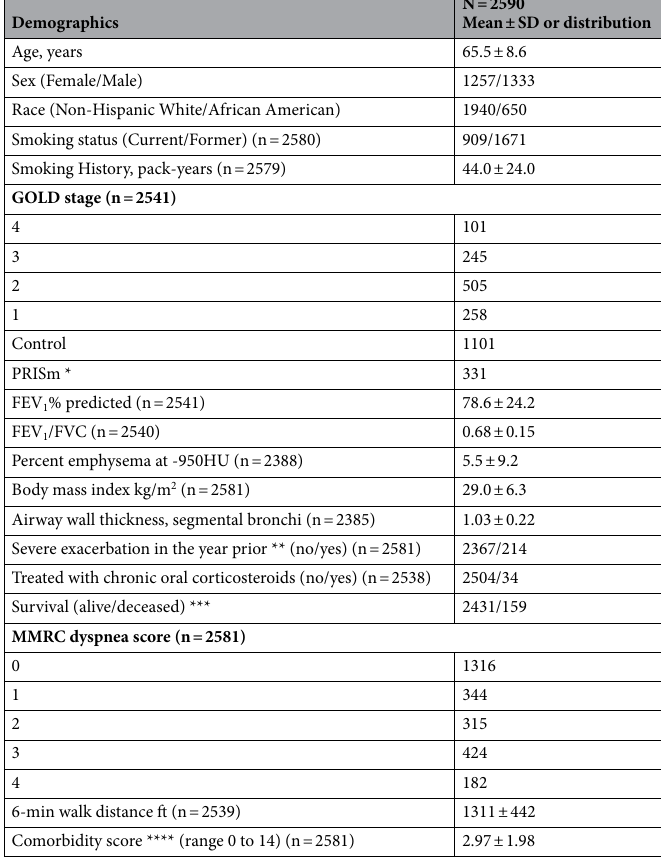
Table 1. COPDGene study subjects. FEV1 = forced expiratory volume in 1 s; FVC = forced vital capacity; PRISm = Preserved Ratio Impaired Spirometry; mMRC = Modified Medical Research Council dyspnea